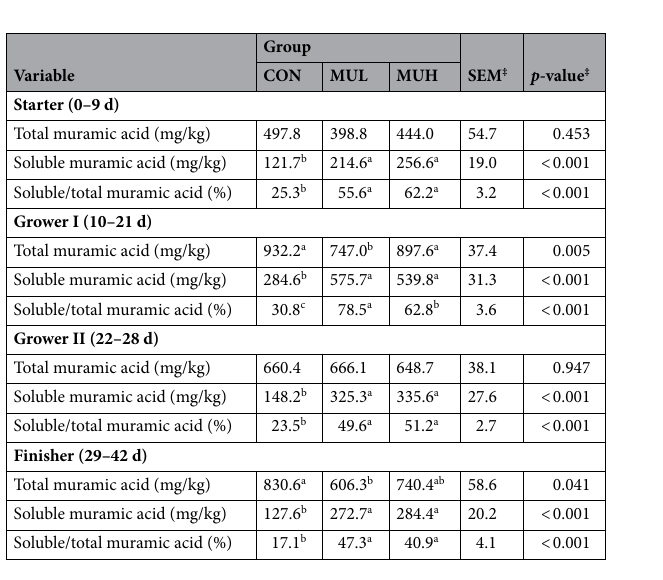
Table 2. Total muramic acid, soluble muramic acid, and their ratio found in excreta samples of CON, MUL, and MUH at the end of each feeding phase † . † Mean values of 12 replicates per group arranged in a randomized complete block design. ‡ Reported values refer to the experimental factor group. a, b Within a row, means with no common superscripts differ significantly ( p -value < 0.05). SEM: Standard error of the